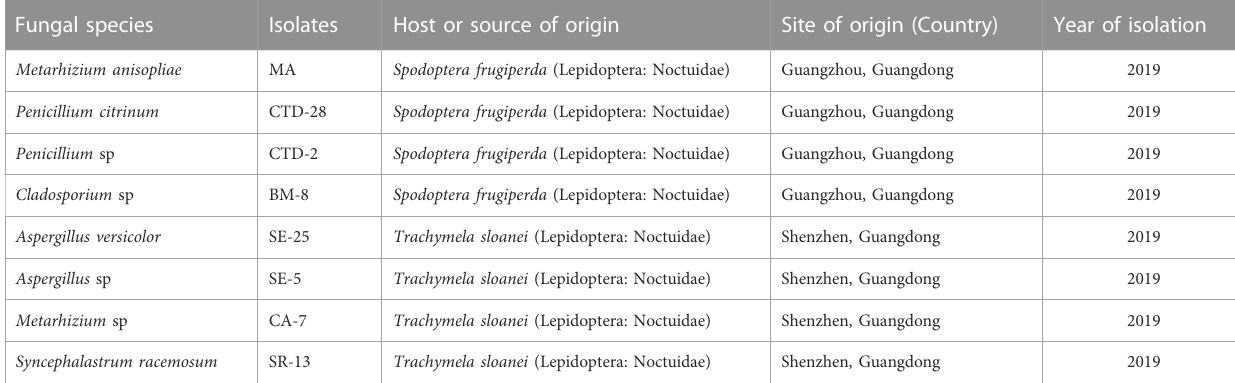
TABLE 1 Information about the fungal isolates evaluated in the present study for the management of fall armyworm. Fungal